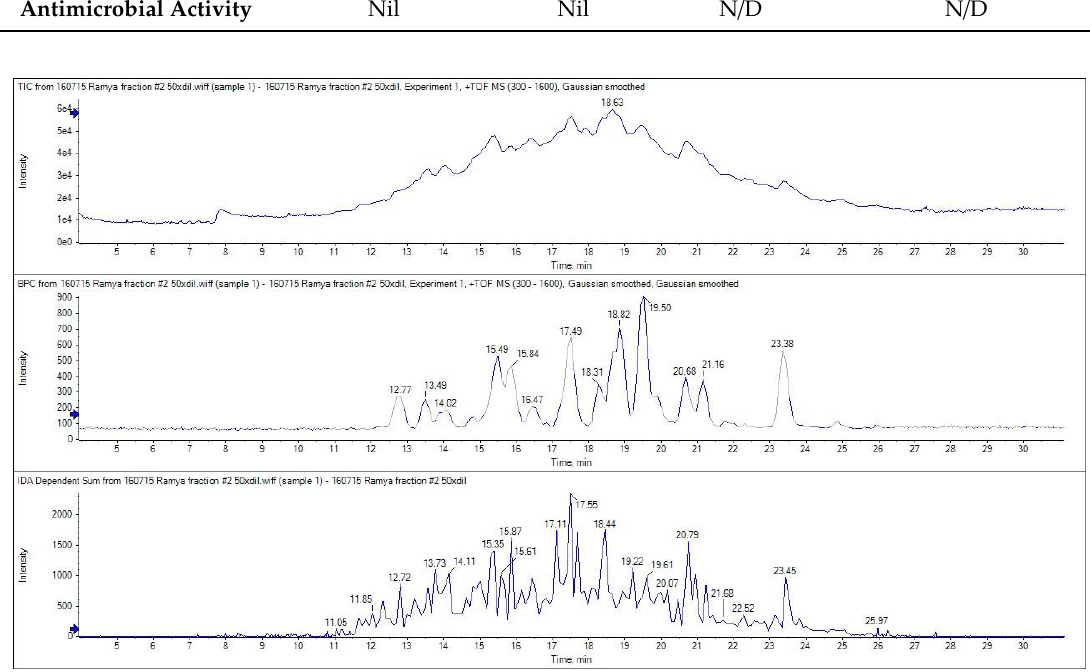
Figure 7. MS/MS spectra of bioactive peptides present in GPH-IV*-P2: ( a ) total ion chromatogram, ( b ) Figure 7. MS / MS spectra of bioactive peptides present in GPH-IV*-P2: ( top ) total ion chromatogram, base peak chromatogram, and ( c ) total MS/MS spectrum. ( middle ) base peak chromatogram, and ( bottom ) total MS / MS